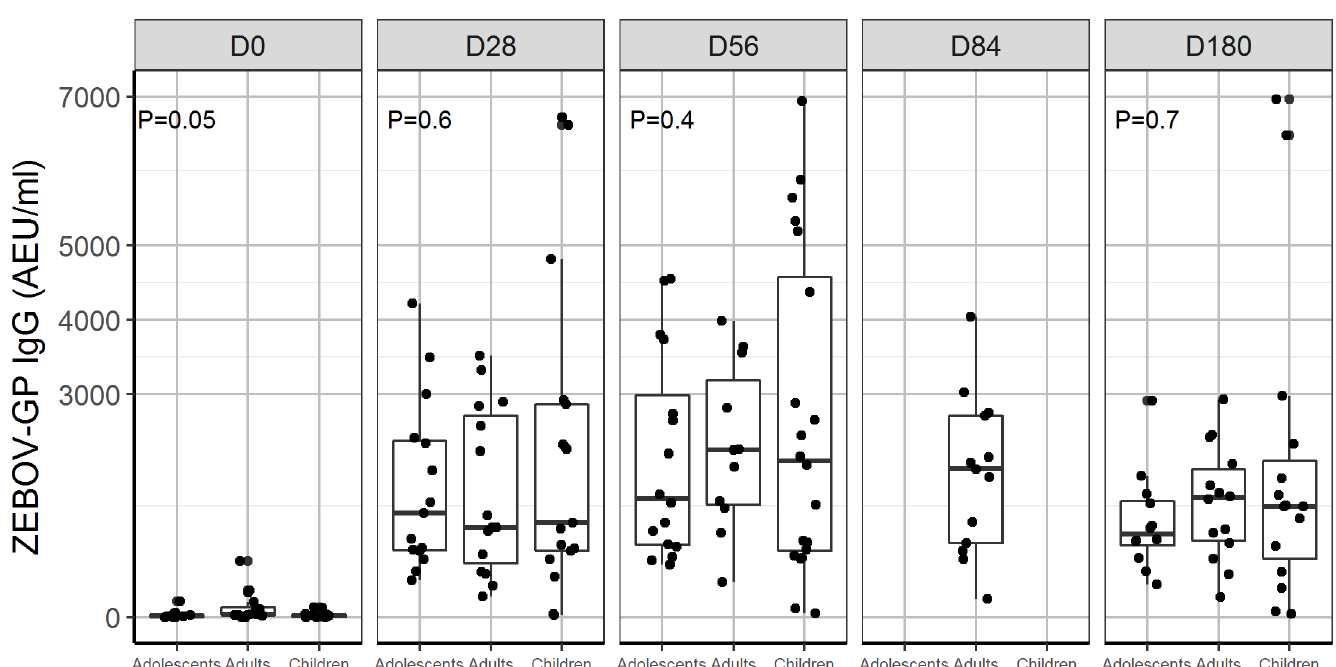
Fig 3. Glycoprotein antibody distribution by age group: Comparison of distribution of ZEBOV-GP IgG antibodies (AEU/ml) measuredby USAMRIID ZEBOV-GP ELISA for dose 2 × 10 7 PFU administered to children, adolescents, and adults from day 0, 28, 56, 84, and 180. Data were not availablefor children and adolescents at D84. P < 0.05 indicatesa statistical difference in ZEBOV-GP IgG betweenchildren,adolescents, and adults. AEU, arbitrary enzyme-linked immunosorbent assay units; ELISA, enzyme-linked immunosorbent assay; GP, glycoprotein; PFU, plaque-forming units;